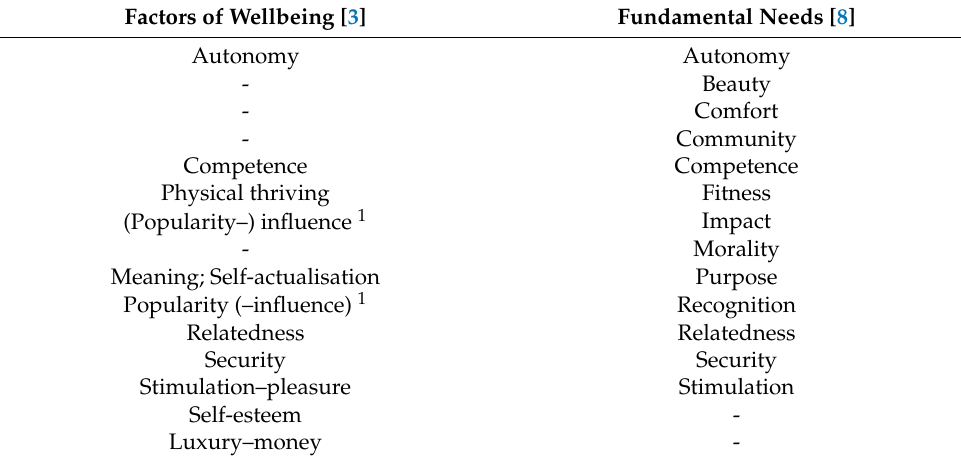
Table 2. Comparison of factors of wellbeing [3] and fundamental needs